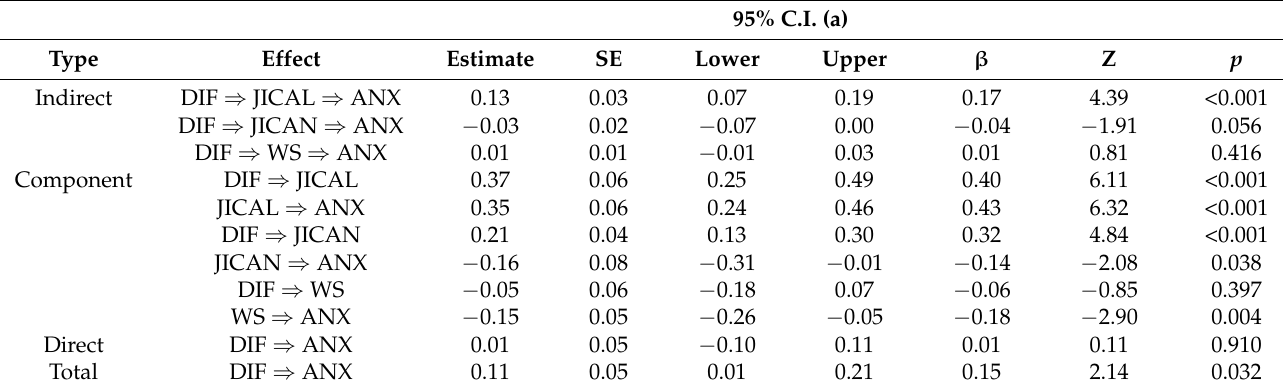
Table 4. Indirect and total effects of predictors on anxiety.